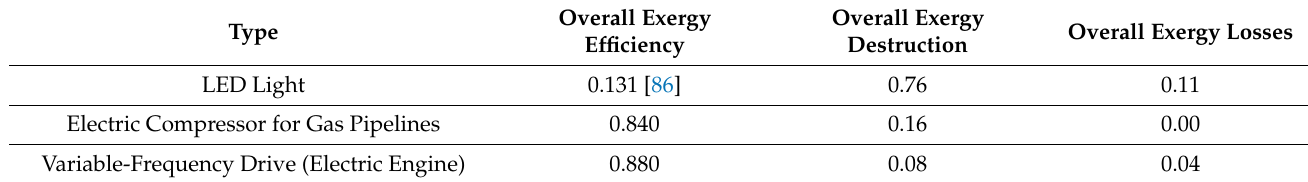
Table A7. Available conversion units for covering other demands of the scenario Energy Efficiency [47].